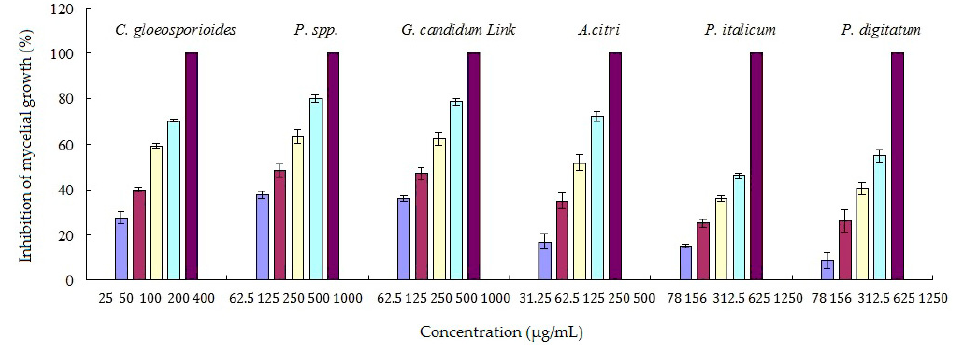
Figure 2. Antifungal activities of cinnamaldehyde against six kinds of citrus pathogens.